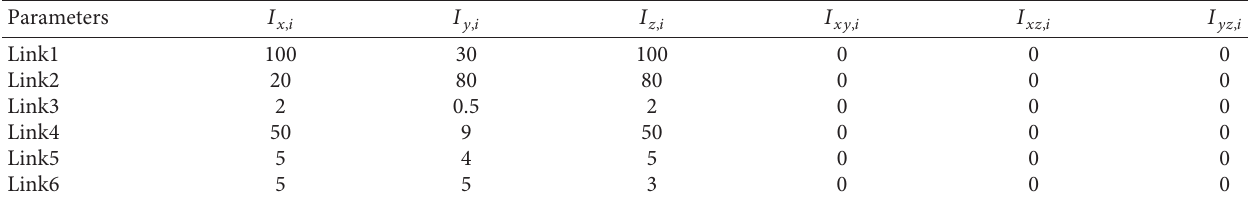
Table 3: Link inertia (Nms 2 ) of the manipulator mounted on the underwater vehicle.